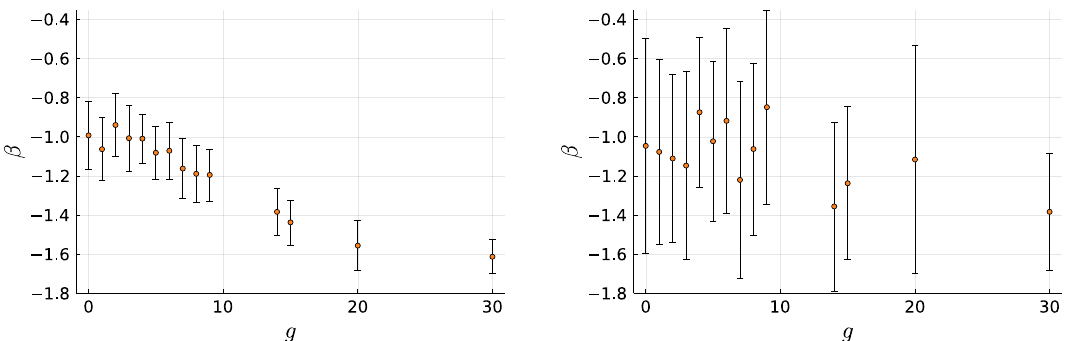
Figure 10. Best fit parameters with associated 95% confidence intervals for the exponent β in the ansatz u ∼ ¯ n β , obtained using two distinct fit ranges. The slice volumes used for the fits in the leftmost plot are ¯ n ∈ { 2250 , 2500 , 5000 , 10000 , 15000 , 20000 } , while for the rightmost plot we used ¯ n ∈ { 5000 , 10000 , 15000 , 20000 }